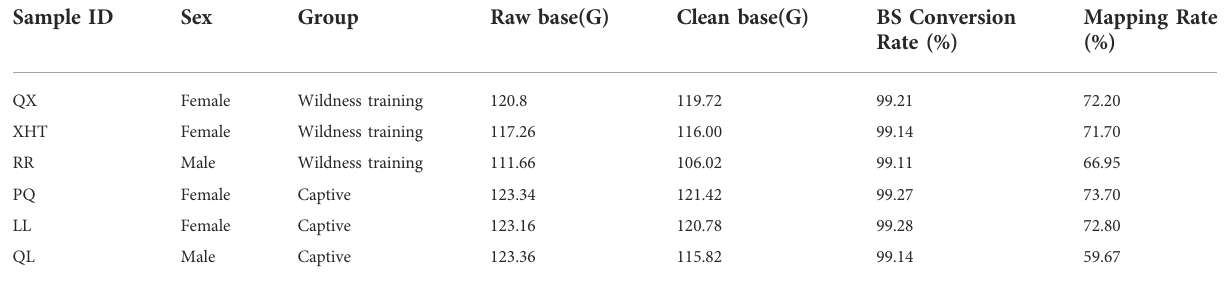
TABLE 1 The methylation sequencing quality and genome coverage of WGBS samples in this study.